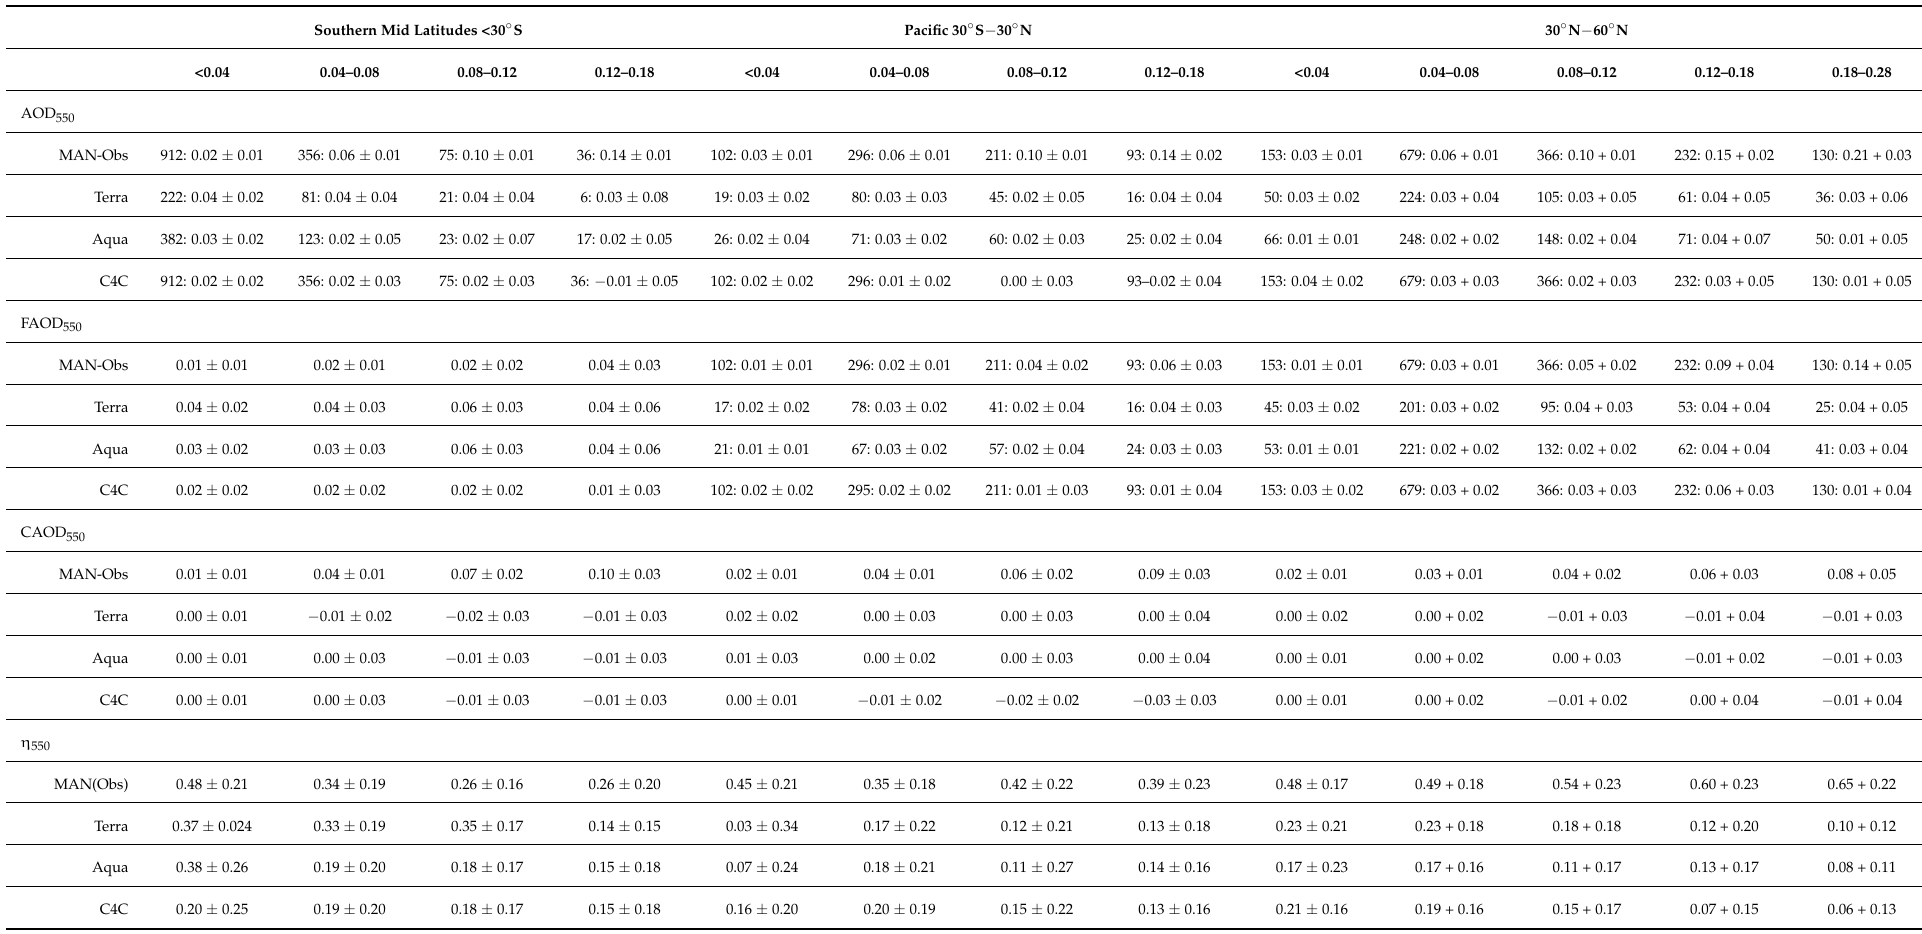
Table 7. Diagnostic error statistics for Terra and Aqua MODIS and the C4C consensus within aerosol optical depth ranges for three regions of the remote ocean. Left columns: Southern oceans (<30 ◦ S); middle columns: central Pacific (30 ◦ S to 30 ◦ N); right columns: Northern mid-latitude oceans (30 ◦ N to 60 ◦